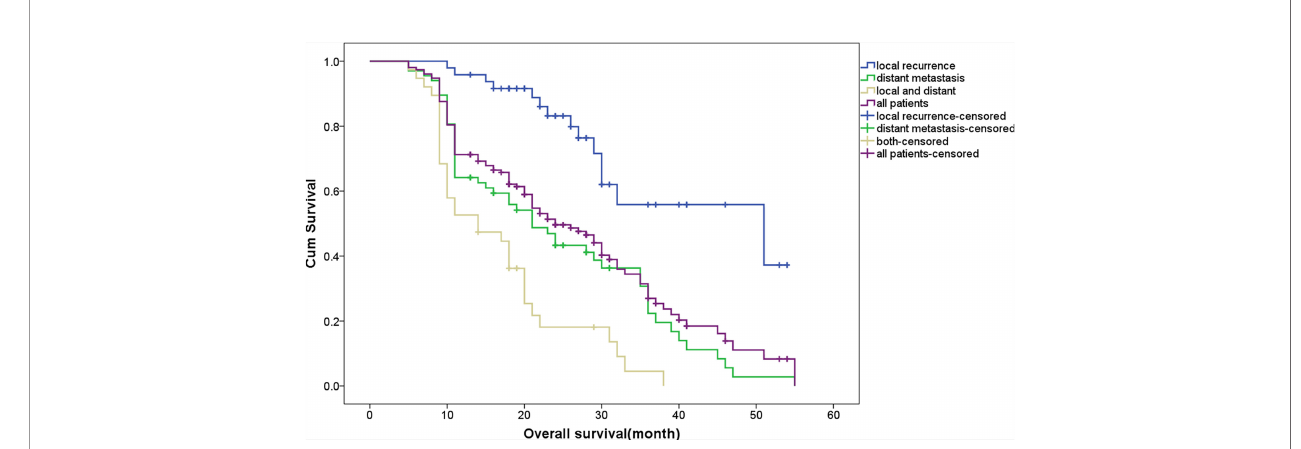
FIGURE 2 | Overall survival comparing different recurrence patterns.